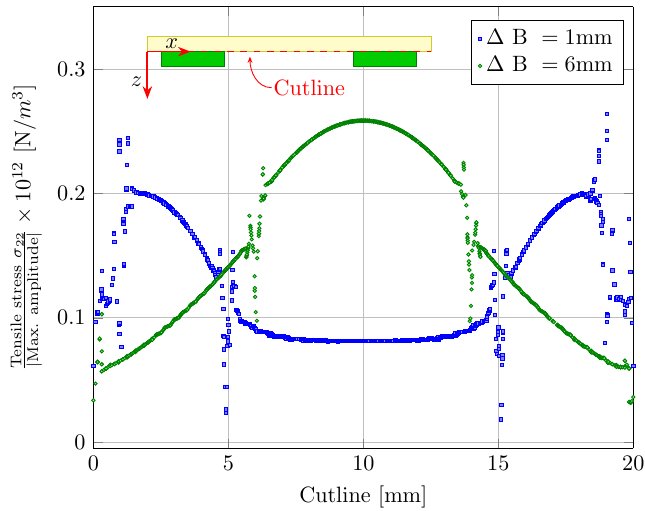
Figure 8. Numerically simulated cost-function (defined in terms of a ratio of tensile stress σ 22 at the piezo to max. absolute output amplitude) across the x -axis